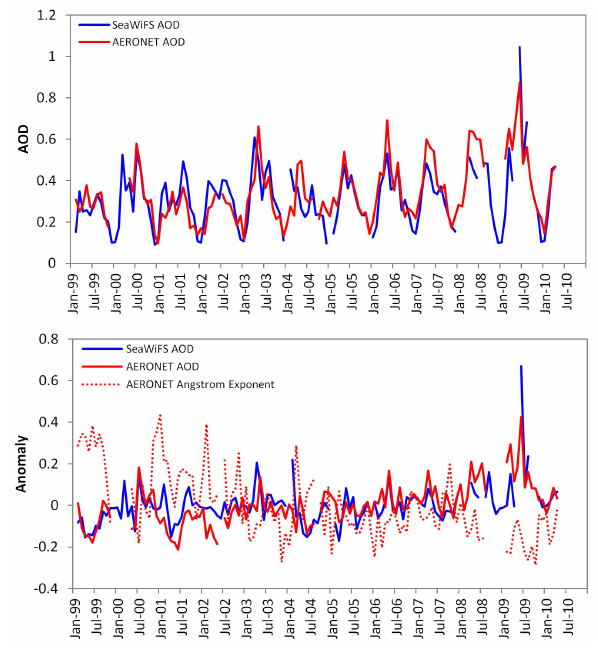
Fig. 13. Interannual variation of AOD (top panel) and AOD anomaly (bottom panel) from SeaWiFS and AERONET measure- ments co-located over the Solar Village site, for the period from February 1999 to April 2010. A systematic increasing aerosol load- ing signal is associated with the strengthening of the seasonal cy- cle, particularly during boreal spring and summer seasons, i.e. peak dust loading period. Interannual variations of Angstrom Exponent anomaly from AERONET data (bottom panel) also suggest a char- acteristic increase in coarse aerosol